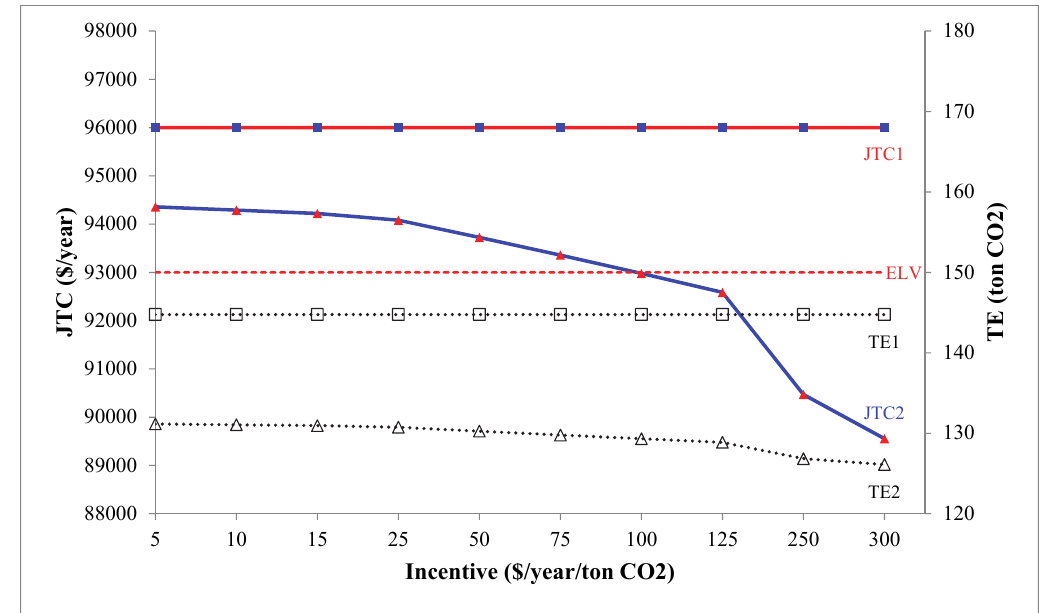
Fig. 5. The effect of changing in incentive on total cost and total GHG